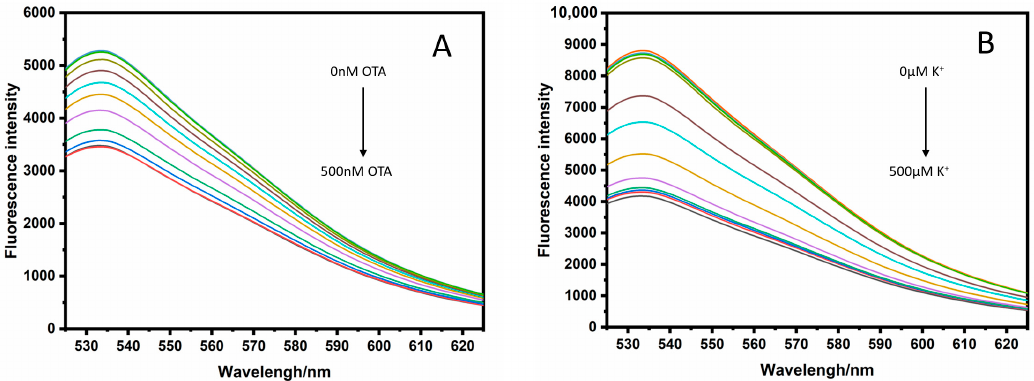
Figure 1. ( A ) Fluorescence emission spectra of unlabeled fluorescence antiparallel G-quadruplex with different concentrations of OTA (0, 0.48, 0.96, 1.95, 3.9, 7.8,15.6, 31.2, 72.5, 125, 250, 500 nM), ( B ) Fluorescence emission spectra of unlabeled fluorescence parallel G-quadruplex with different concentrations of K + (0, 0.48, 0.96, 1.95, 3.9, 7.8,15.6, 31.2, 72.5, 125, 250, 500 µM).